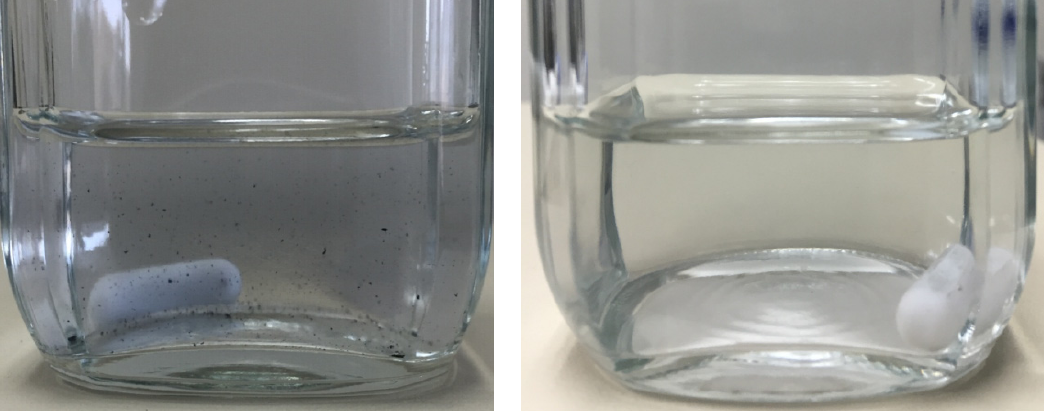
Figure 3. Aquadag samples of presonication (left) and post-sonication (right) after long-term placement.